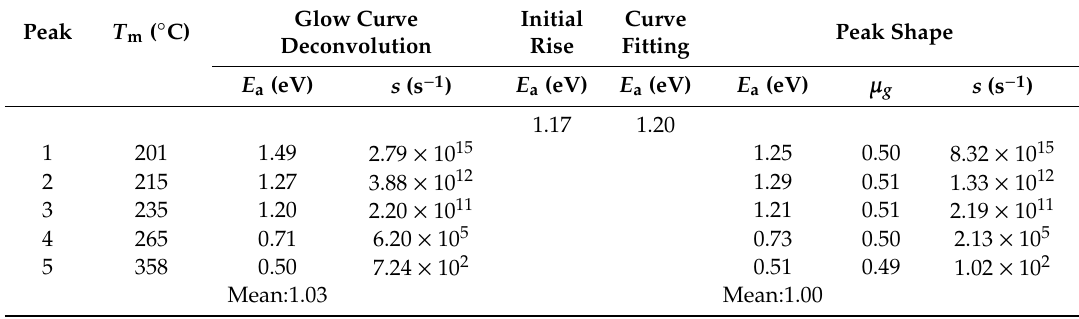
Table 4. The kinetic parameters obtained by di ff erent methods of ZnB 2 O 4 :0.03Tb 3 + for a 30 Gy. Glow Curve Peak T m ( ◦ C)